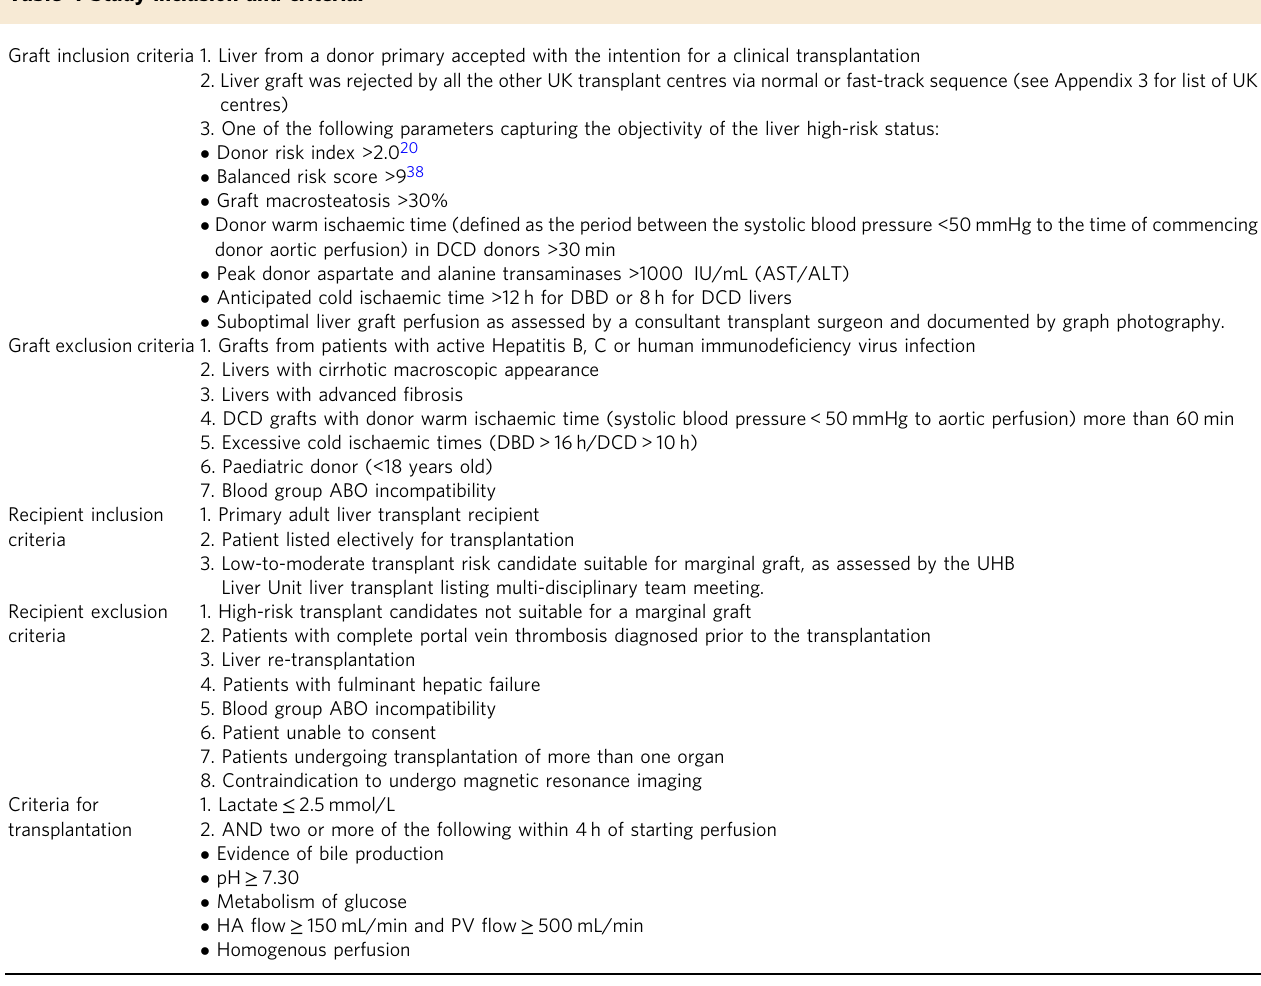
Table 4 Study inclusion and criteria. Graft inclusion criteria 1. Liver from a donor primary accepted with the intention for a clinical transplantation 2. Liver graft was rejected by all the other UK transplant centres via normal or fast-track sequence (see Appendix 3 for list of